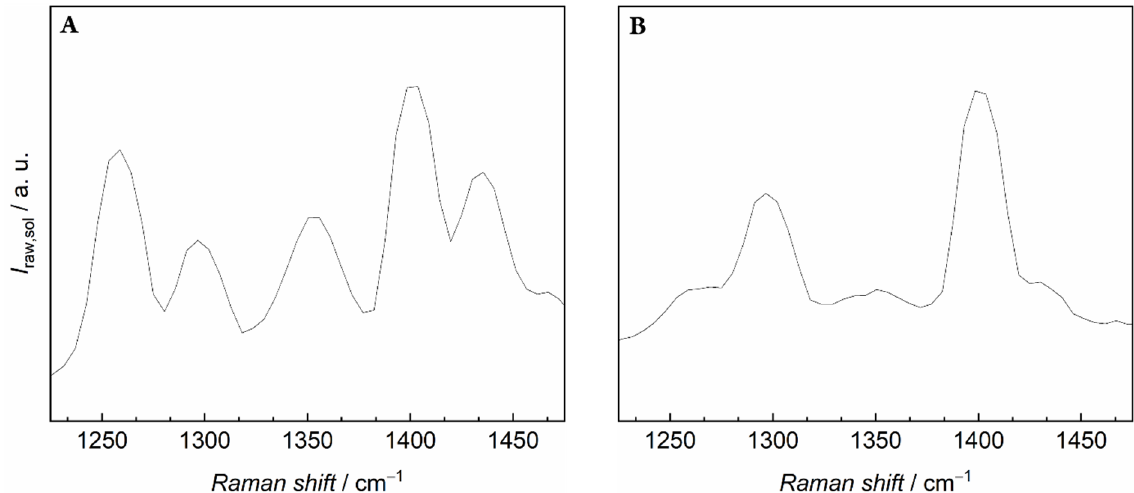
Figure 4. Raman spectra of dissolved carbon dioxide in [Bmim][Tf 2 N] at p = 3.0015 MPa and T = 293.21 K. ( A ) Original spectrum without further processing in the relevant Raman shift range. ( B ) Spectrum of the revealed carbon dioxide Fermi dyad after subtraction of the Raman spectrum in vacuum.